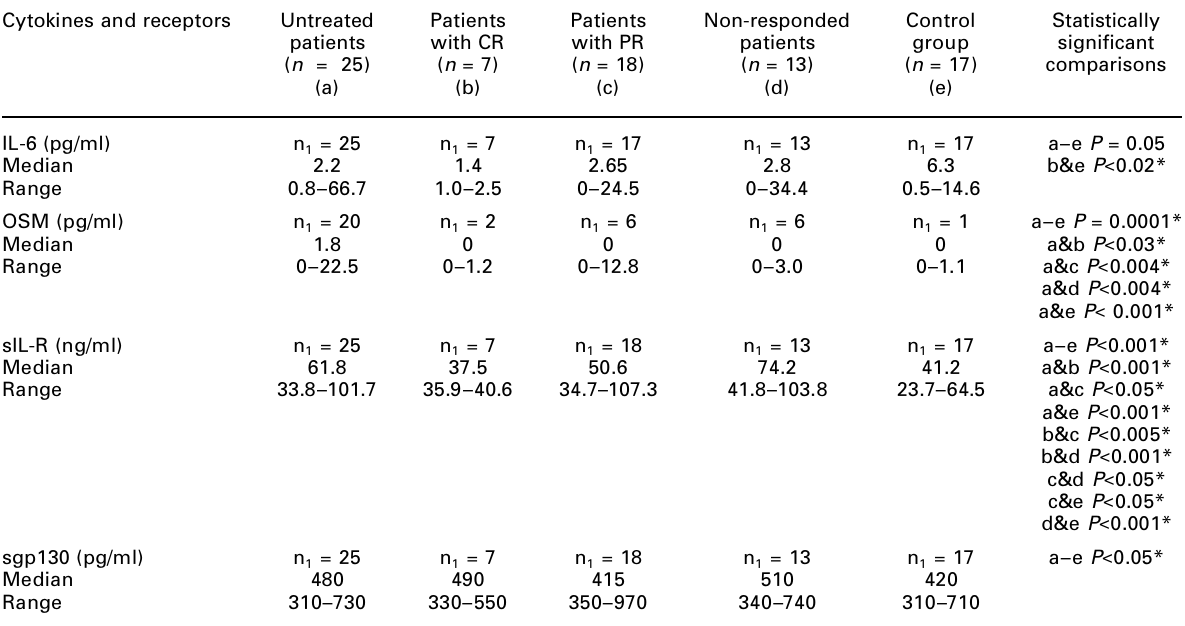
Table 3. Serum levels of IL-6, OSM, sIL-6R and sgp130 in patients with CLL according to treatment response. Median and range in parentheses Cytokines and